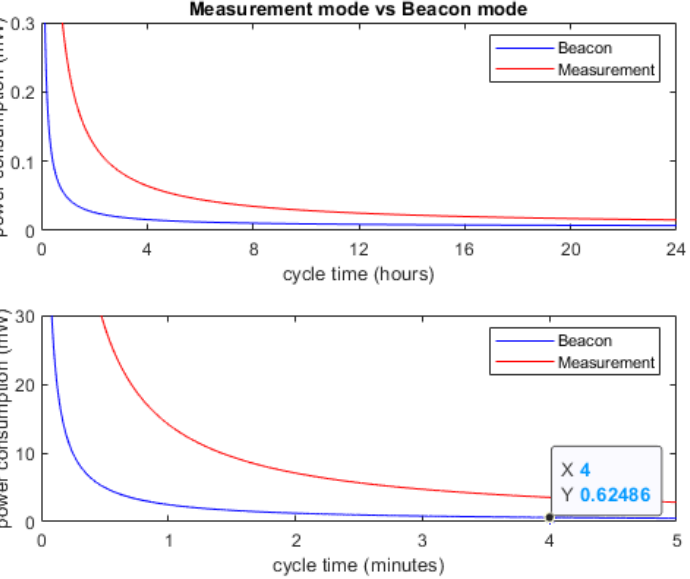
Figure 12. Sensor Node: average power consumption for the Measurement and the Beacon modes.